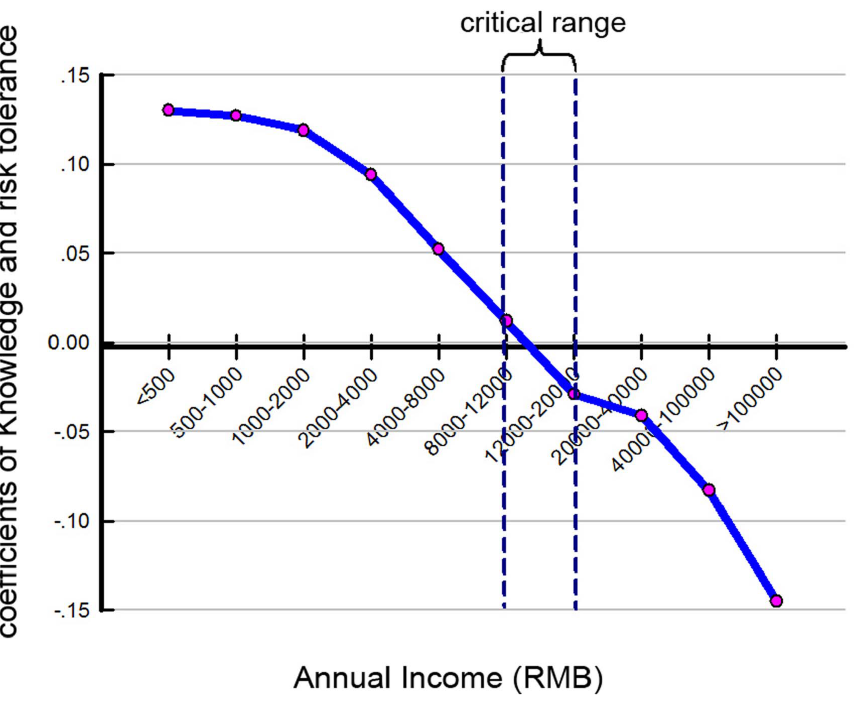
Figure 3. Regression analysis between annual income and the coefficients of Knowledge and risk tolerance.